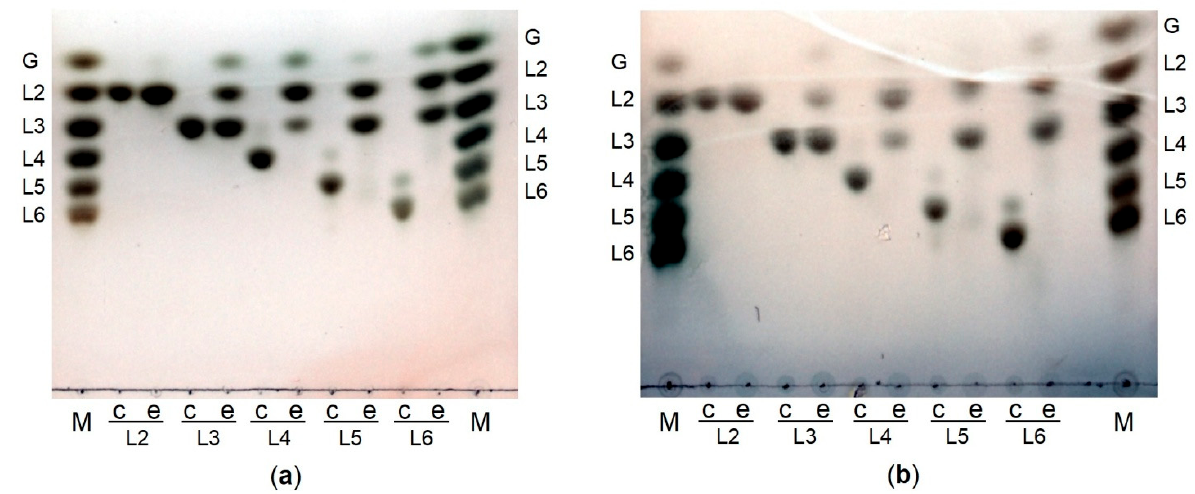
Figure 5. TLC analysis of hydrolysis products. Hydrolysis of laminari-oligosaccharides (laminaribiose (L2), laminaritriose (L3), laminaritetraose (L4), laminaripentaose (L5), laminarihexaose (L6) by PSLam81A ( a ) and PsLam81A ∆ CBM56 ( b ). Carbohydrate standards (M): glucose (G), laminaribiose (L2), laminaritriose (L3), laminaritetraose (L4), laminaripentaose (L5) laminarihexaose (L6). Reactions were carried out in the presence (e) and absence (c) of the enzyme.